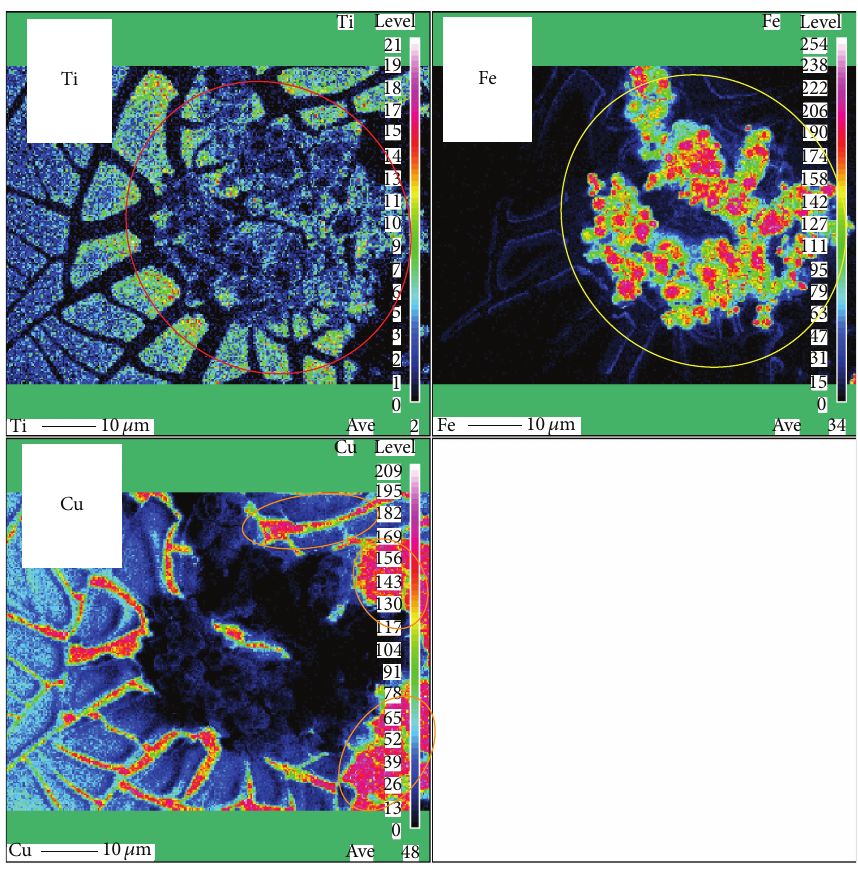
Figure 11: EPMA image of Fe/TiO 2 film coated on Cu